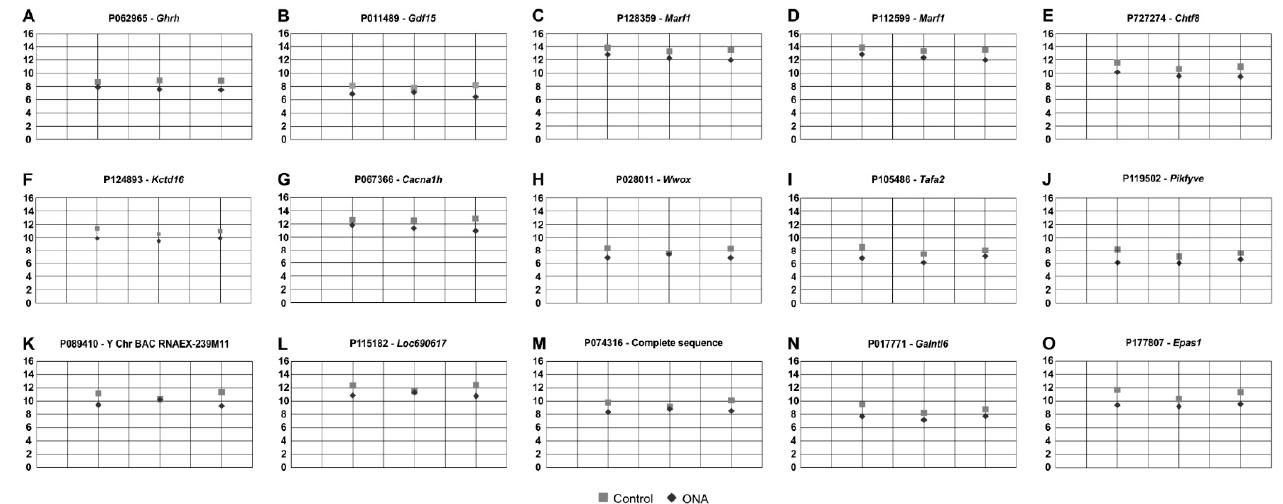
Figure 7. Downregulated regulated oligonucleotide probes. ( A – O ) The 15 oligonucleotide probes found downregulated in ONA rats following microarray analysis of the inner retinal layers. All plots display the normalized fluorescence intensity (y-axis) of ONA and control animals (x-axis). Based on the results of the microarray assays, we performed additional RT-qPCR analyses of the most up- and downregulated genes ( p < 0.05). Amongst others, Hba-a1 ( p = 0.006), Hbe2 ( p = 0.009), and Cxcl10 ( p = 0.039) were found upregulated in the ONA reti- nae in the microarray analysis. RT-qPCR analysis revealed no alterations in mRNA expression levels of Hba-a1 in ONA retinae (0.64-fold expression; p = 0.202; Figure 8A). Additionally, Hbe2 mRNA ex- pression levels were unaltered after ONA immunization (2.28-fold expression; p = 0.204; Figure 8B). An upregulation of the mRNA expression levels of Cxcl10 was found in the ONA group in RT-qPCR experiments (2.33-fold expression; p = 0.033; Figure 8C). Figure 8. Cxcl10 upregulation. ( A ) RT-qPCR analyses revealed no differences in the Hba-a1 mRNA levels in ONA retinae. ( B ) The mRNA expression levels of Hbe2 were unaltered after ONA immun- ization. ( C ) An upregulation of the Cxcl10 mRNA expression levels was found in the ONA group ( p = 0.033). Values are median ± quartile ± minimum/maximum. The dotted lines represent the relative expression of the control group. * p < 0.05.